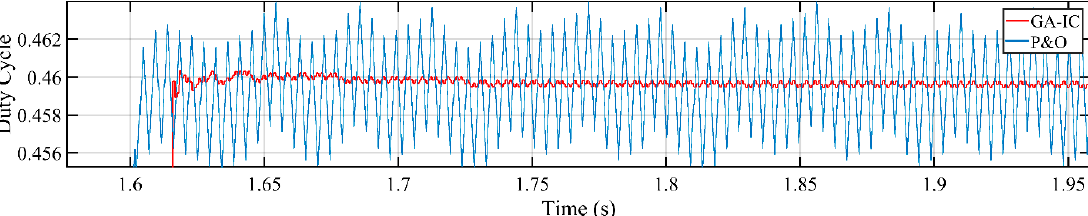
Figure 15. Case 1 duty cycle, zoomed in view of modified GA-IC vs. P&O.